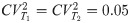
Contributions from different noise sources as a function of the timing of genome duplication for CVT12=CVT22=0.05.Different noise components in Eq (46) are plotted as a function of β, which represents the fraction of time within the cell cycle at which gene duplication occurs. The mean protein level is held constant by simultaneously changing the transcription rate kx. Noise levels are normalized by their respective value at β = 0. The noise contribution from partitioning errors is maximized at β ≈ 0.6. In contrast, the contribution from stochastic expression is minimum at β ≈ 0.6. The extrinsic noise contribution from random gene-duplication and cell-division events is maximum at β ≈ 0.2 and minimum at β ≈ 0.8. For this plot, the mean of the protein is 170 molecules per cell; and the bursts are geometrically distributed with 〈B〉 = 10.